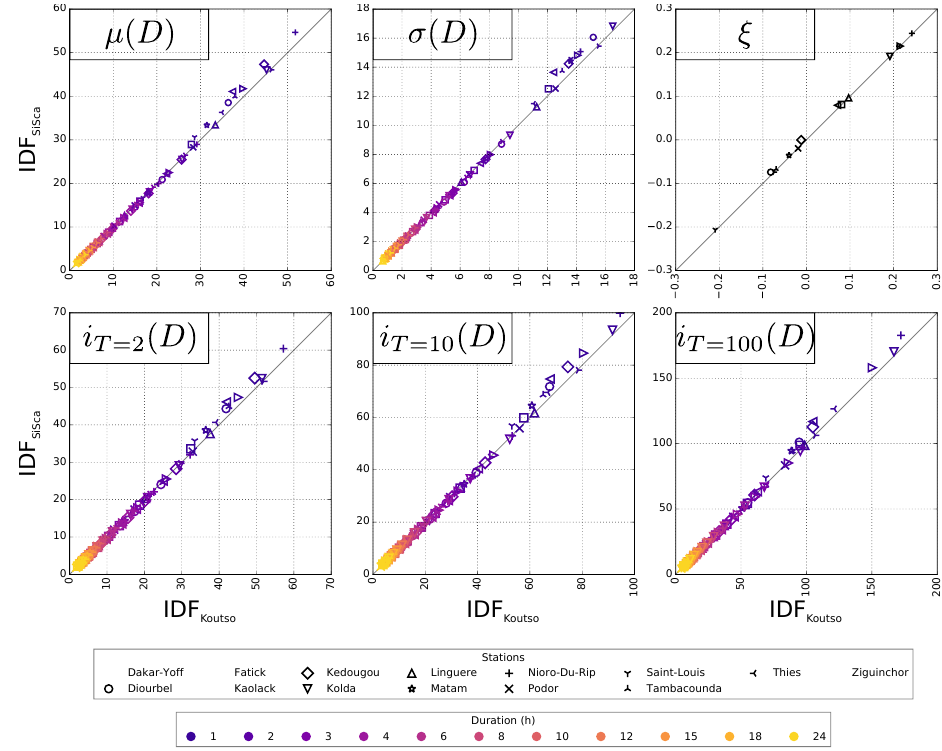
Figure 6. Comparison between IDF SiSca and IDF Koutso in calibration mode. Top panels: location parameter – µ(D) [mmh − 1 ]; scale pa- rameter – σ(D) [mmh − 1 ]; and shape parameter – ξ [–]. Bottom panels: return levels – i T [mmh − 1 ] – obtained for different return periods T ranging from 2 to 100 years